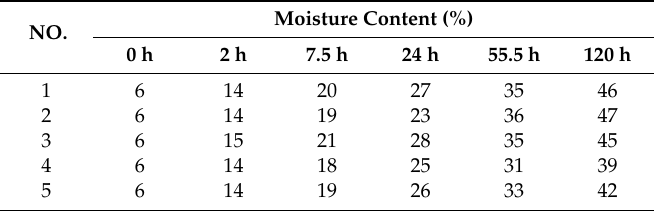
Table 2. Moisture content of the soaked core-samples.